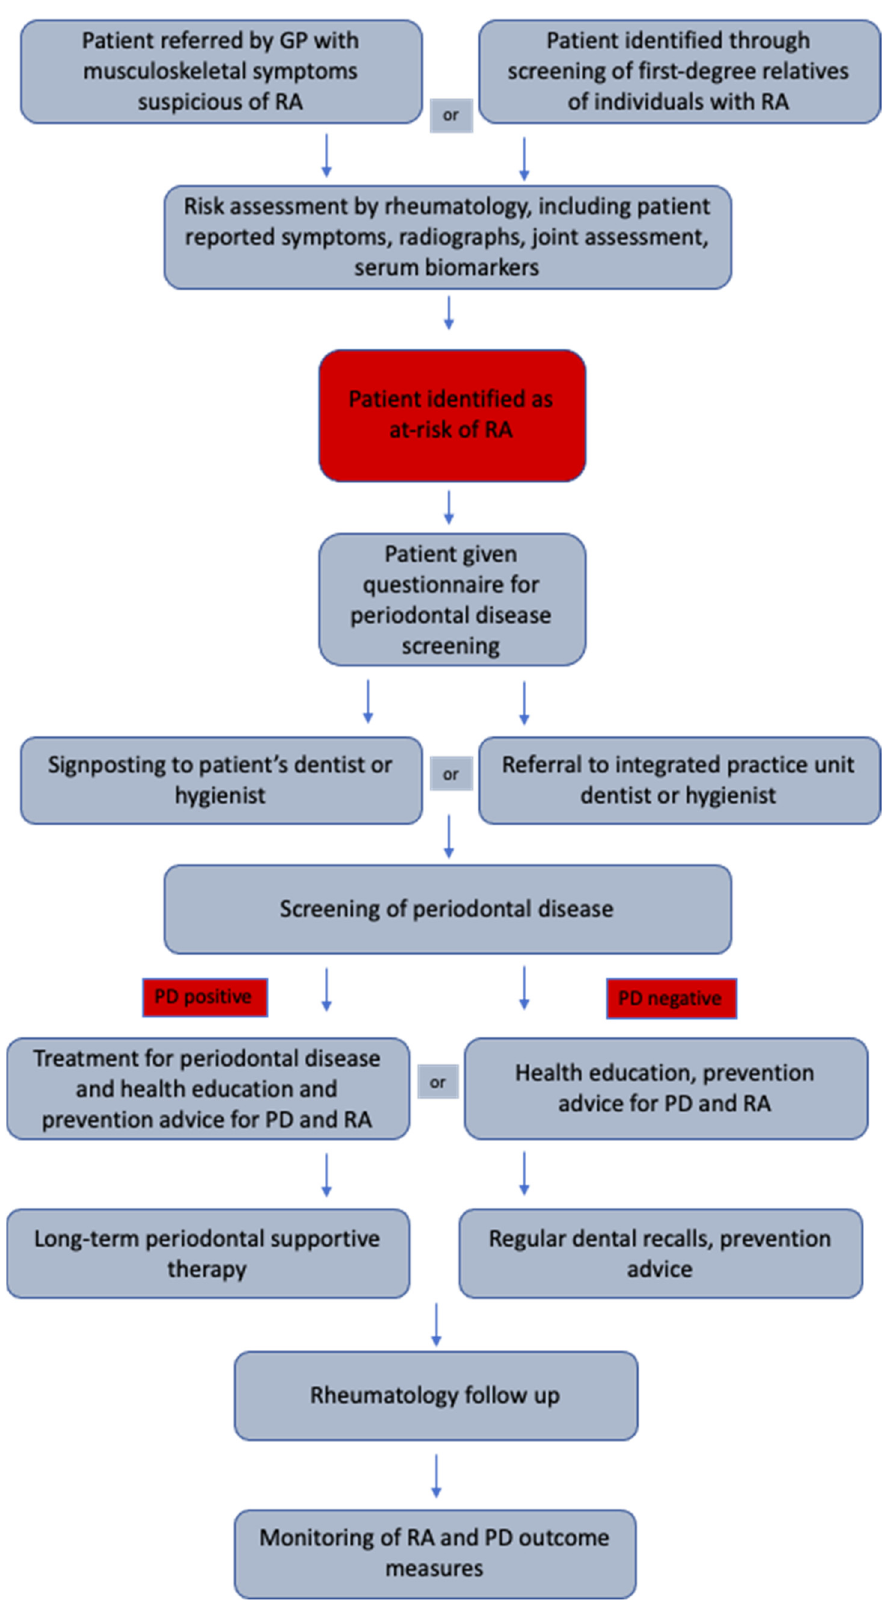
Figure 1. Proposed pathway for screening and treating of periodontal disease for at risk of RA disease patients in secondary care.